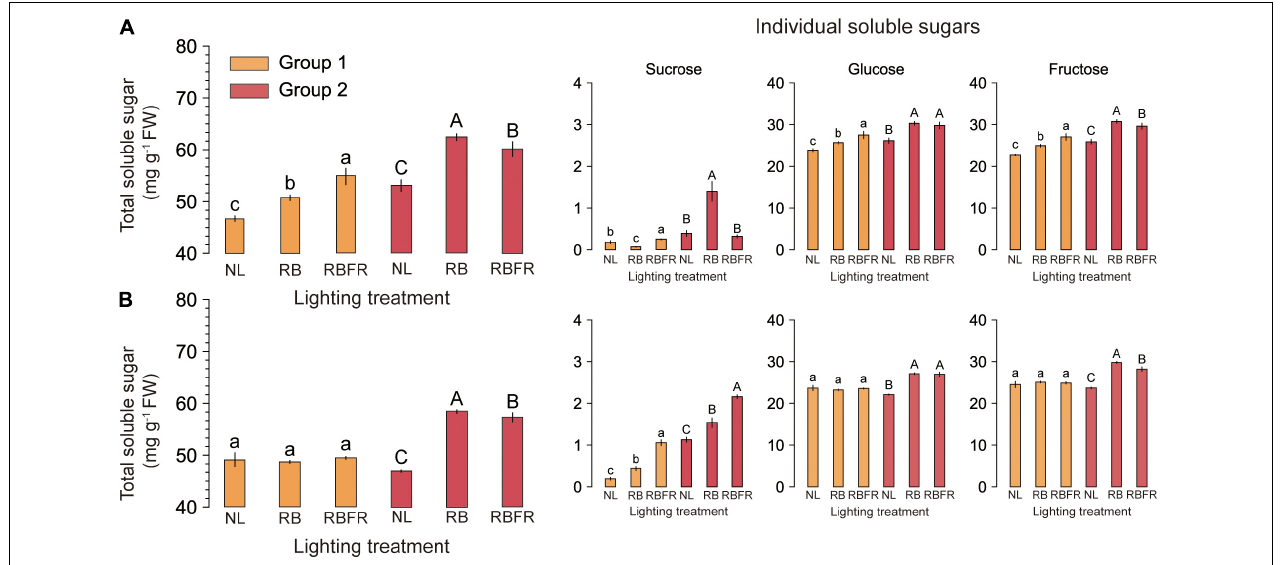
FIGURE 3 | Total and individual soluble sugar concentrations of fully ripened red (A) and yellow (B) fruits of sweet peppers grown under natural light (NL), NL with red + blue LED interlighting (RB), and RB with far-red light (RBFR), respectively. Different letters indicate significance for light treatments within the same fruit color, as determined by Tukey’s HSD test, α = 0.05. Mean ± SD (n = 5). The total soluble sugar was calculated by adding the individual soluble sugars. Groups 1 and 2 indicate fruits sampled at different harvesting periods as shown in Figure 1